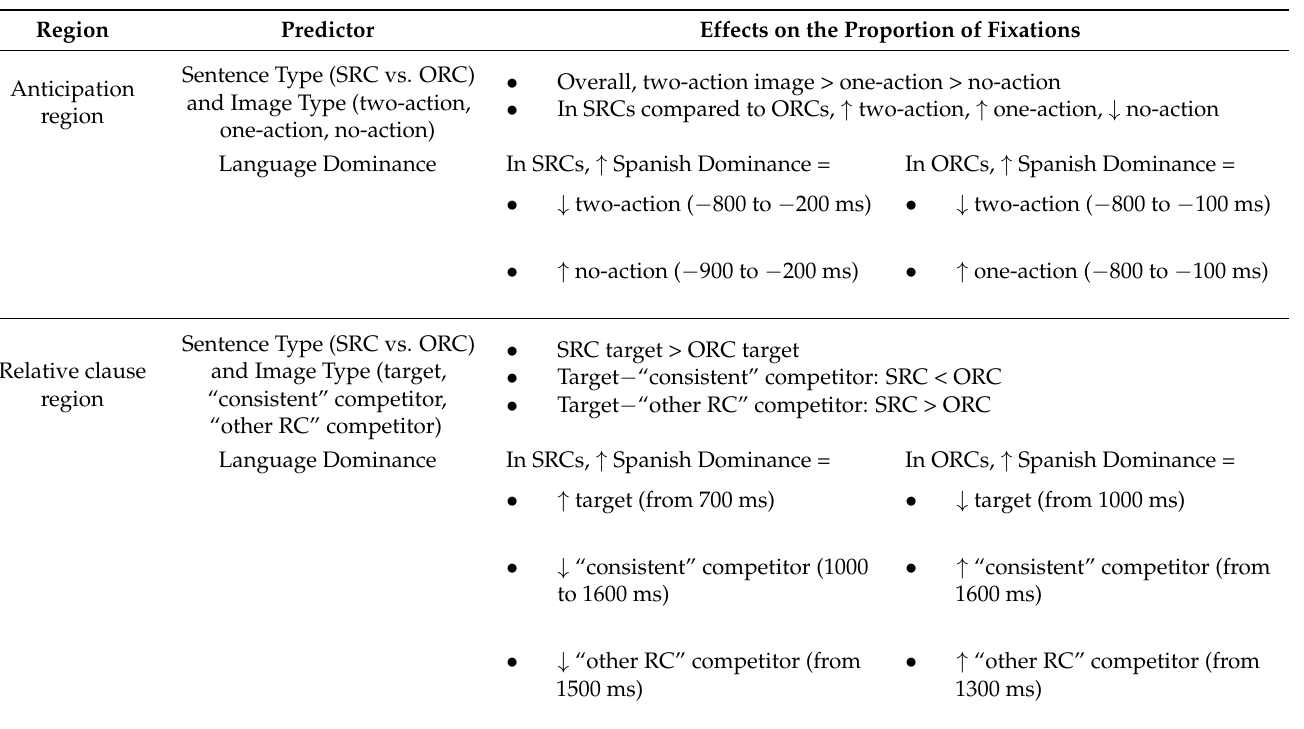
Table 6. Summary of main findings from each region, including main effects of predictors (Sentence Type, Image Type, Language Dominance) and their interactions. In the relative clause region, effects that are apparent continuations of effects from the anticipation region are not reported. The greater-than (>) and less-than (<) signs indicate inequalities between levels of a factor, and the minus sign (–) represents the difference between levels of a factor. Upward ( ↑ ) and downward ( ↓ ) arrows indicate increases and decreases, respectively, of the variable to their right. In the anticipation region, the timestamps between parentheses reflect milliseconds before the onset of the relativizer que . In the relative clause region, they reflect milliseconds after the onset of the relativizer. Effects on the Proportion of